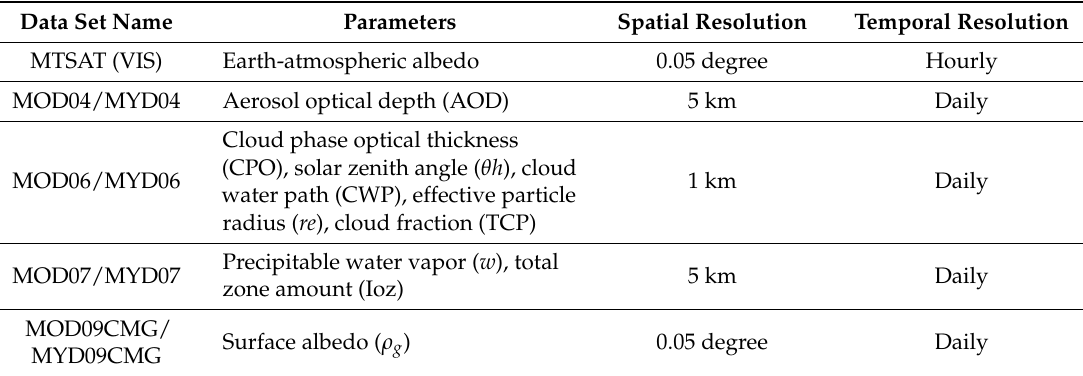
Table 2. Basic information about Moderate Resolution Imaging Spectroradiometer (MODIS) and Multi-Functional Transport Satellite (MTSAT) products used in this study.